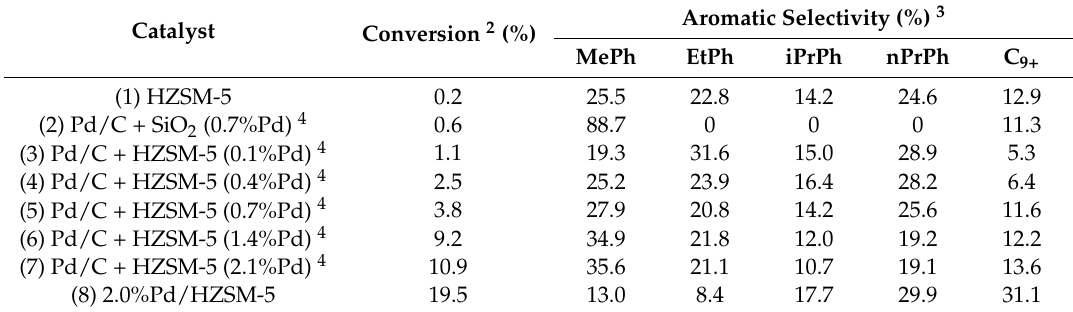
1 Reaction conditions: 300 °C, 1 bar pressure, 0.20 g catalyst, inlet molar ratio C 6 H 6 /C 3 H 8 = 1:9, 10 mL min − 1 flow rate, W / F = 80 g h mol − 1 ; catalyst pre ‐ treatment at 300 °C/1 h in H 2 flow, 10 mL min − 1 . 2 Benzene conversion at 3 h time on stream. 3 Selectivity to unidentified C 9+ alkylbenzenes at 3 h time on stream. 4 Uniform physical mixture of 7.1% Pt/C with HZSM ‐ 5 or SiO 2 .